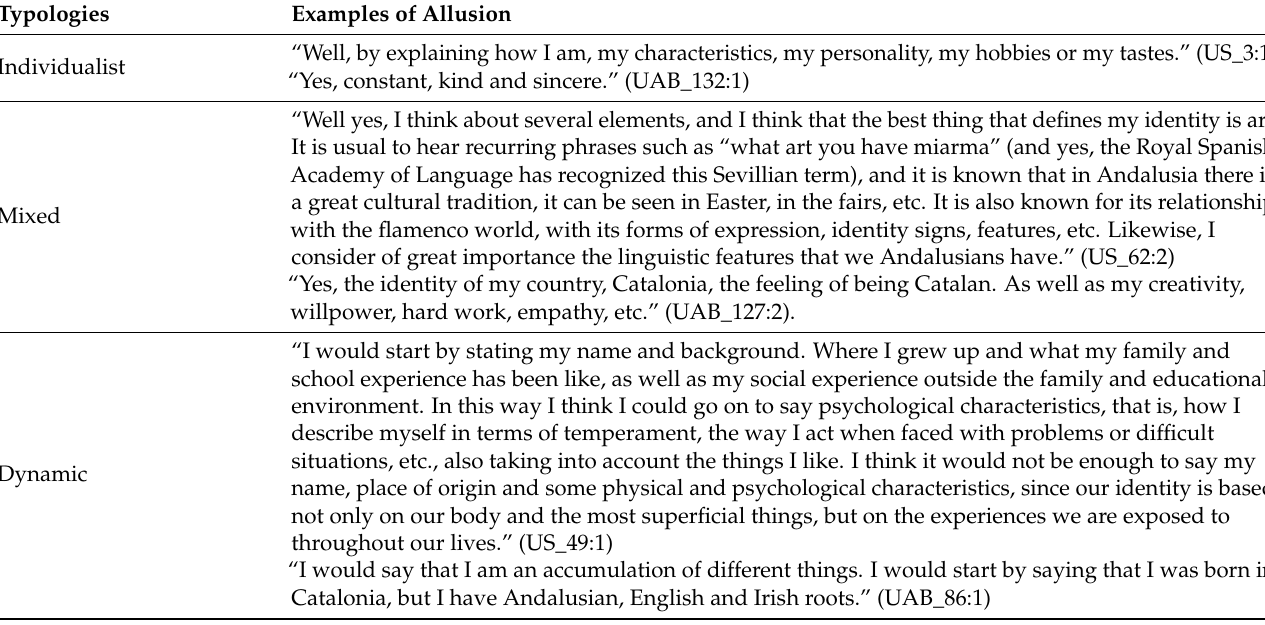
Table 6. Examples of allusion quotations on typologies.